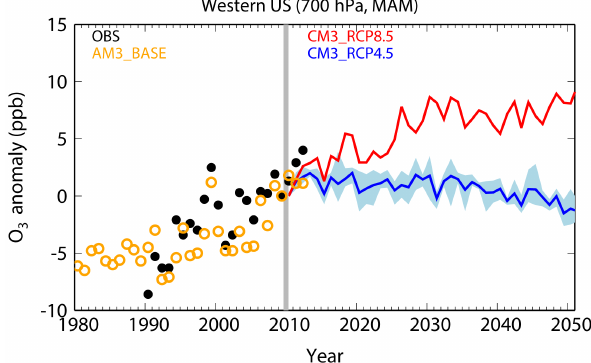
Figure 14. Future projections. Time series of median springtime O 3 changes relative to 2010 in GFDL AM3 hindcast (orange circles) and CM3 future simulations for RCP8.5 (red) versus RCP4.5 (blue; shading represents the range of three ensemble members), sampled at 700hPa over the WUS (35–45 ◦ N, 120–105 ◦ W). Black circles indicate observed changes averaged from the Lassen, Great Basin, and Rocky Mountain national parks.